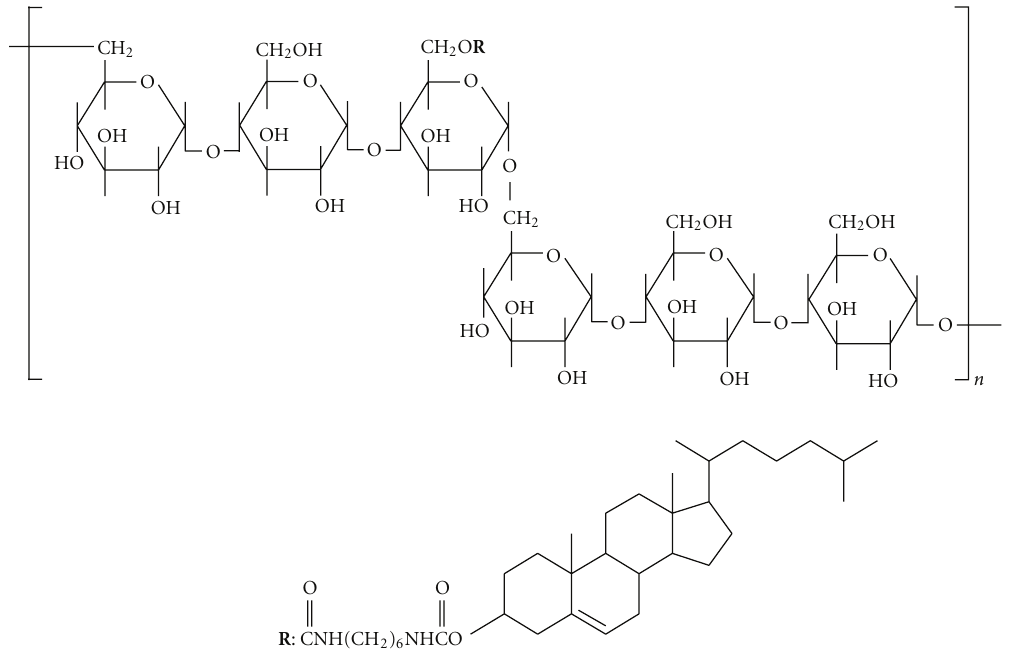
Figure 6: Chemical structure of cholesterol-bearing pullulan